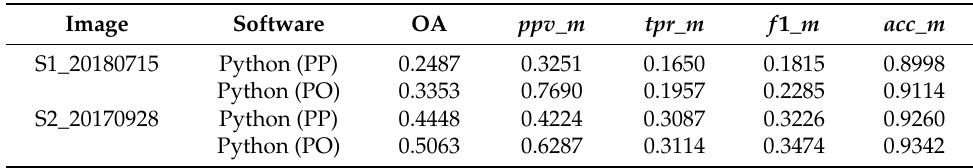
Figure 5. The impact of the image registration date and the number of classified images on the accuracy of classification- selected indicators: OA and f 1 m . Classification is performed in our own Python scripts with RFC algorithm. Accuracy assessment in our own scripts: Python (PP) and Python (PO). Table 12. The accuracy metrics related to RF classification made on entire training set (1,312,093 pixels) calculated from the entire test set in the pixel (1,412,092 pixels) and in the object-oriented (2386 parcels) approach Python (PP) and